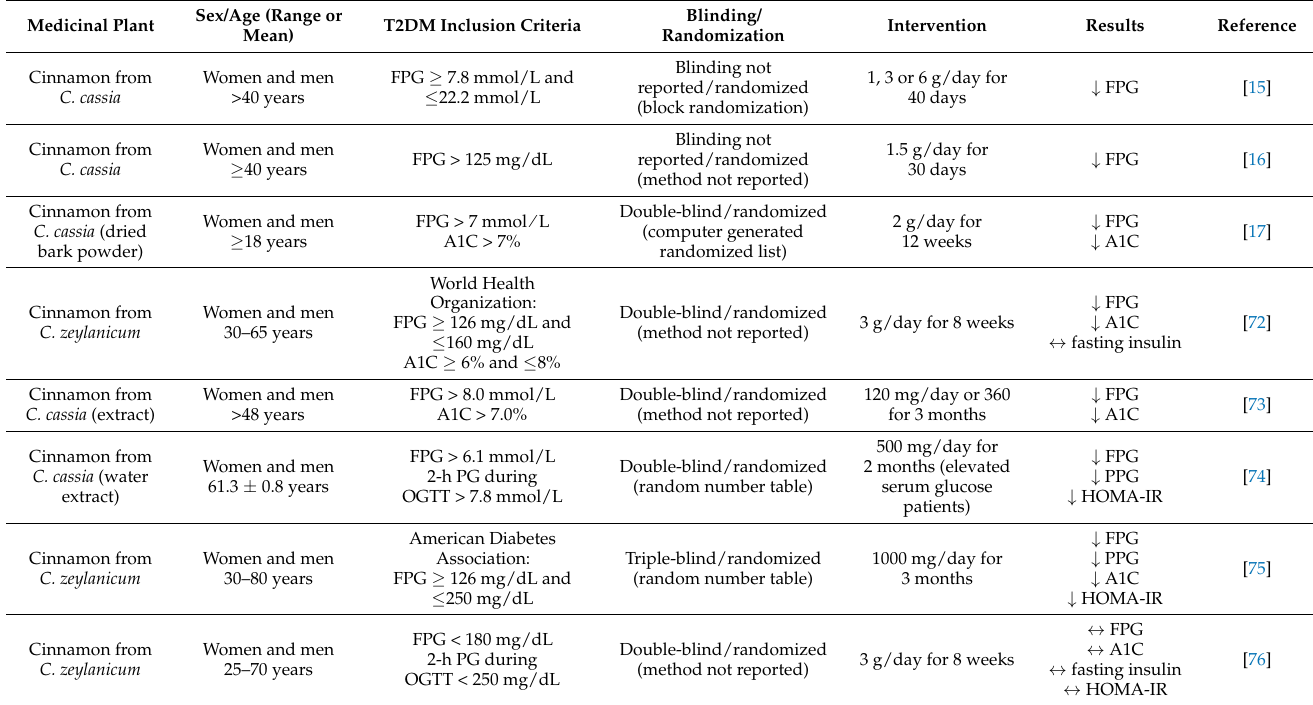
Table 2. Cinnamon: clinical evidence in type 2 diabetes